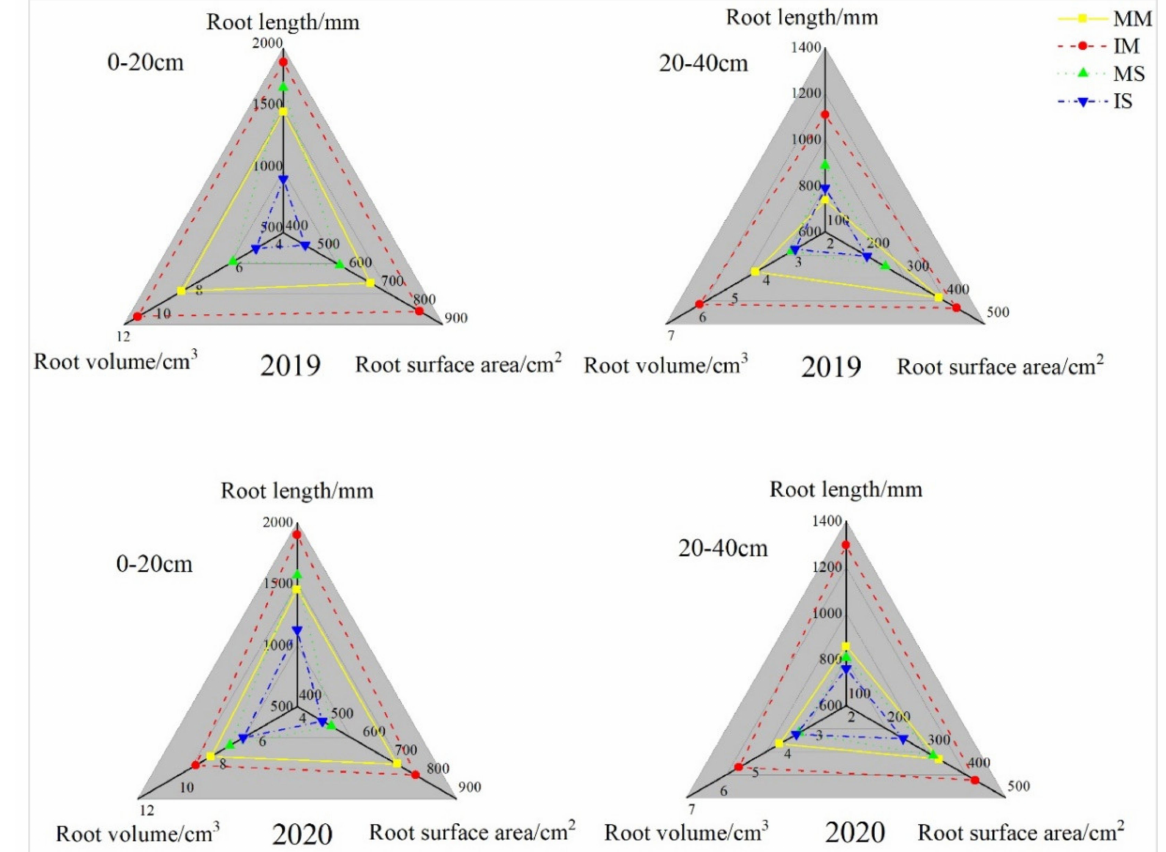
Figure 5. Dynamic changes of root morphological characteristics of maize and soybean in mono- culture and intercropping during 2019 and 2020. Abbreviations: MM—monocropping maize, MS—monocropping soybean, IM—intercropping maize, IS—intercropping